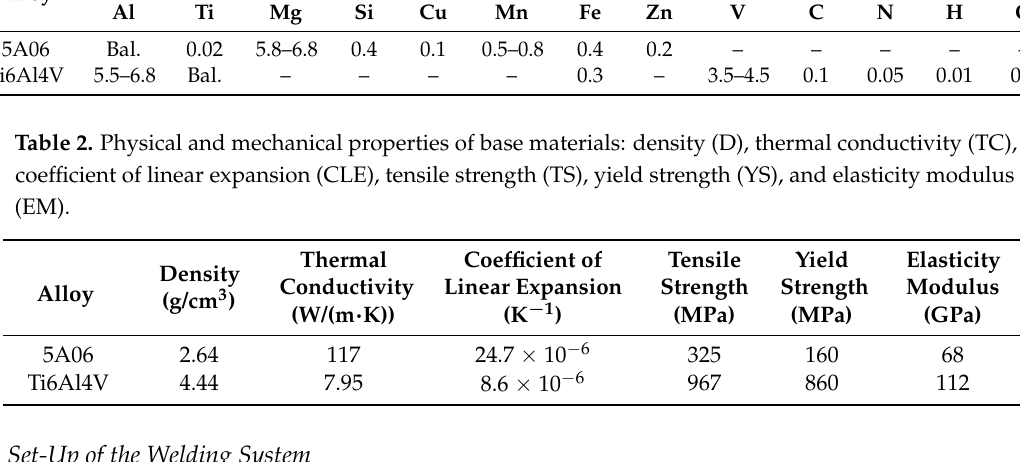
Table 3. The process parameters.